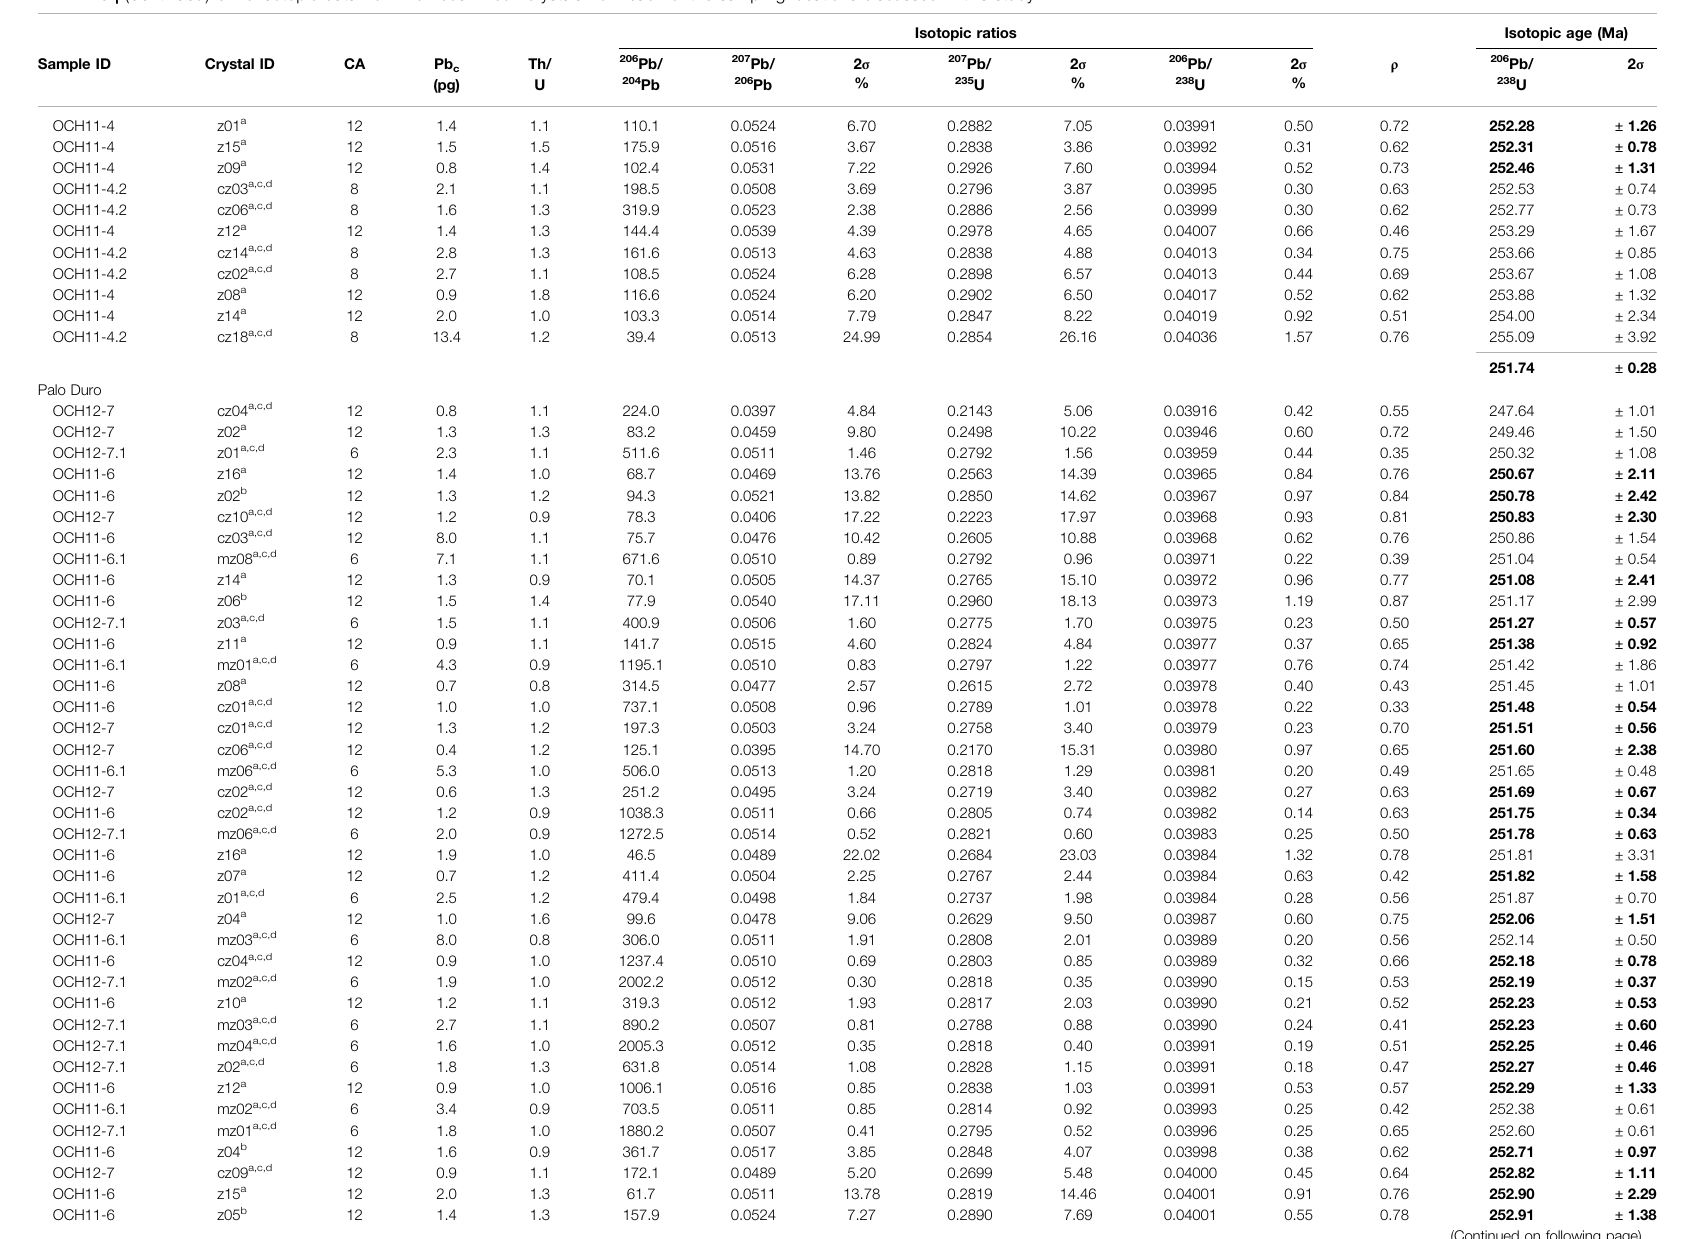
TABLE 3 | ( Continued ) U-Pb isotopic data from individual zircon crystals from each of the sampling locations discussed in this